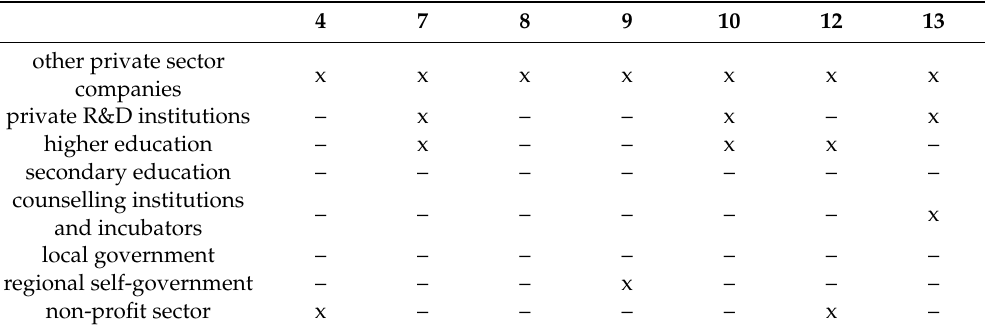
Table 7. Collaborating actors in generating product and process innovations in the sample.